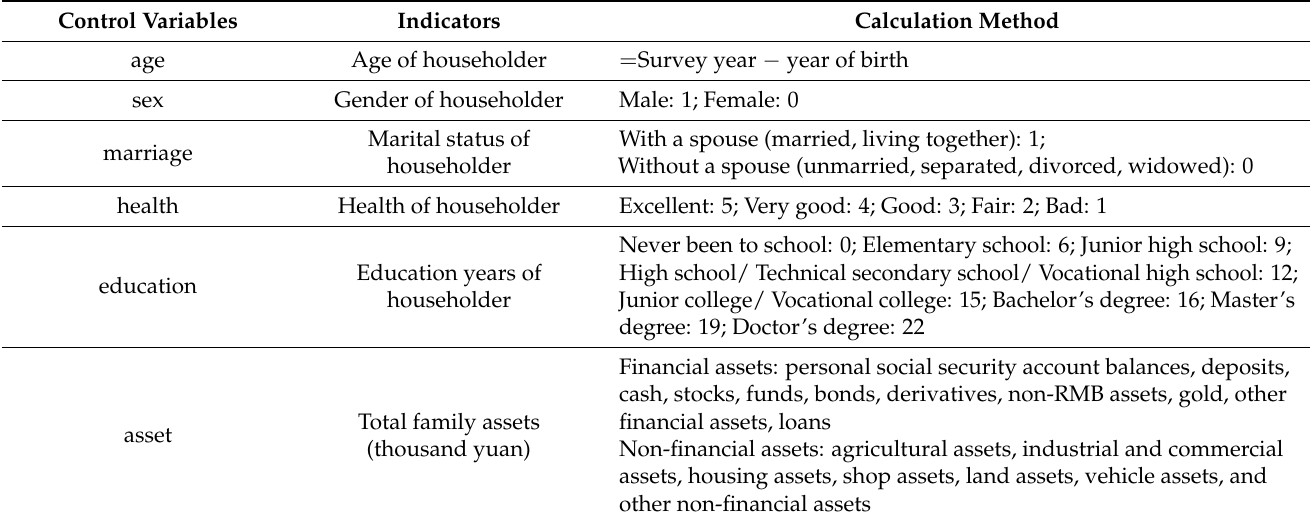
Table 2. Control